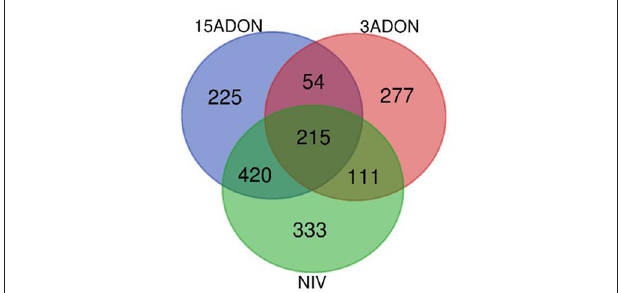
FIGURE 3 | A Venn diagram of differentially expressed genes (FDR ≥ 0.05) for contrasts of Fusarium treatment (3ADON, 15ADON, and NIV chemotypes) vs. mock control under the additive generalized linear model